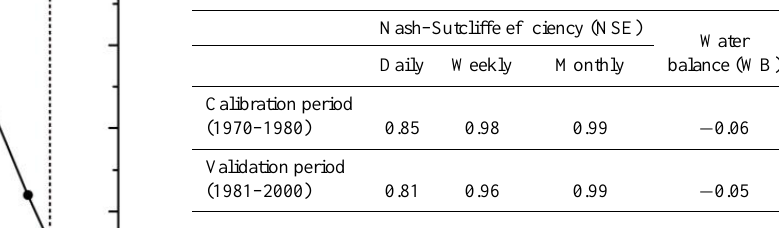
Table 1. Calibration and validation statistics for the simulated streamflow of UHRB at Danjiangkou reservoir